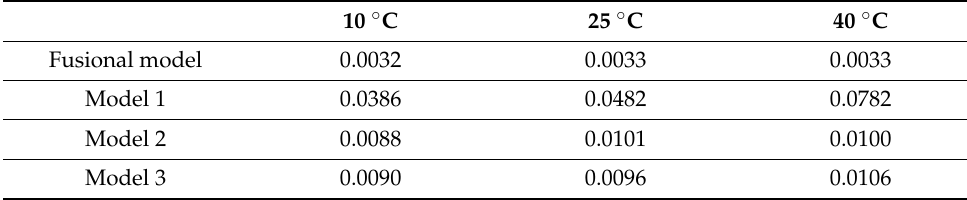
Figure 10. OCV models of LFP battery at 10 °C, 25 °C, and 40 °C. ( a ) Fusional OCV model at 10 °C. ( b ) Conventional OCV models at 10 °C. ( c ) Fusional OCV model at 25 °C. ( d ) Conventional OCV models at 25 °C. ( e ) Fusional OCV model at 40 °C. ( f ) Conventional OCV models at 40 °C. Table 6. RMSE of fusional OCV models and other models for LFP battery